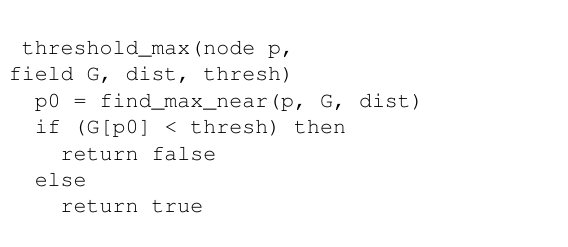
requirement that there exists another node p0 within distance